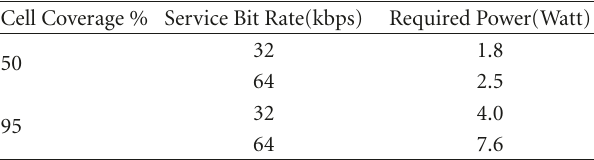
Table 1: Indicative FACH Tx power